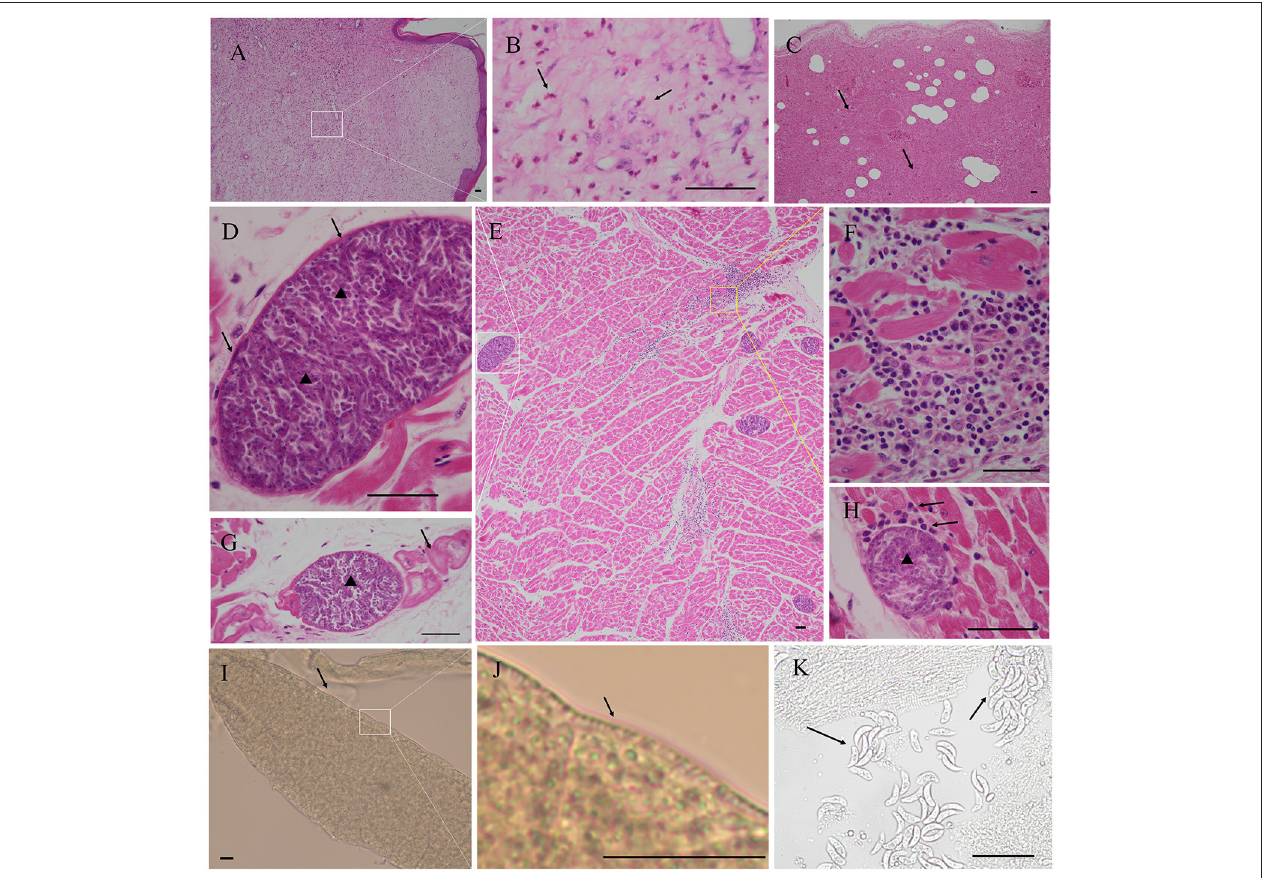
FIGURE 1 | Pathological findings in the myocardium of case 1 alpaca ( Vicugna pacos ). (A) Granulation tissue was observed in skin phyma. (B) Magnification of picture A; note the presence of numerous eosinophils (arrow), skin phyma. (C) Severe interstitial pneumonia, necrosis, and exudation were observed in the lung (arrow). (D) Magnification of picture E; Sarcocystis masoni cysts were observed in the myocardium, the sarcocyst was separated by septa and formed several rooms, and the bradyzoites were arranged in packets (arrowhead), thin wall (arrow). (E) Presence of numerous S. masoni cysts in the myocardium. (F) Magnification of picture E, myocardial necrosis, and many lymphocytes, macrophages, and plasma cell infiltration. (G) S. masoni (arrowhead) in Purkinje fibers (arrow). (H) Inflammatory responses (arrow) around the degenerated S. masoni sarcocyst (arrowhead) in the myocardium and mononuclear cell infiltration (arrow). (I) S. masoni sarcocyst was found in the pepsin digestion liquid. Thin wall, unstained. (J) Magnification of picture I; short and scattered villar protrusions were visible. (K) S. masoni bradyzoites in the pepsin digestion liquid, unstained. Hematoxylin-eosin (H, E) staining; bar = 50 µ